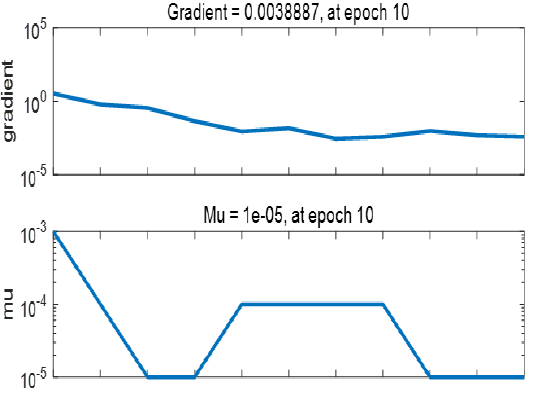
Figure 29. Gradient curve graph.